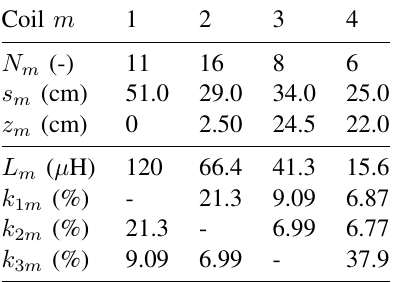
TABLE I G EOMETRY DESCRIPTION WITH NUMBER OF TURNS N m OF L ITZ WIRE ( (cid:11) = 10 mm ), OUTER SIDE LENGTH s m AND AXIAL POSITION z m OF THE COILS SHOWN IN F IG . 1 ENUMERATED BY m = 1 ,..., 4 AND CORRESPONDING INDUCTANCE AND COUPLING COEFFICIENTS